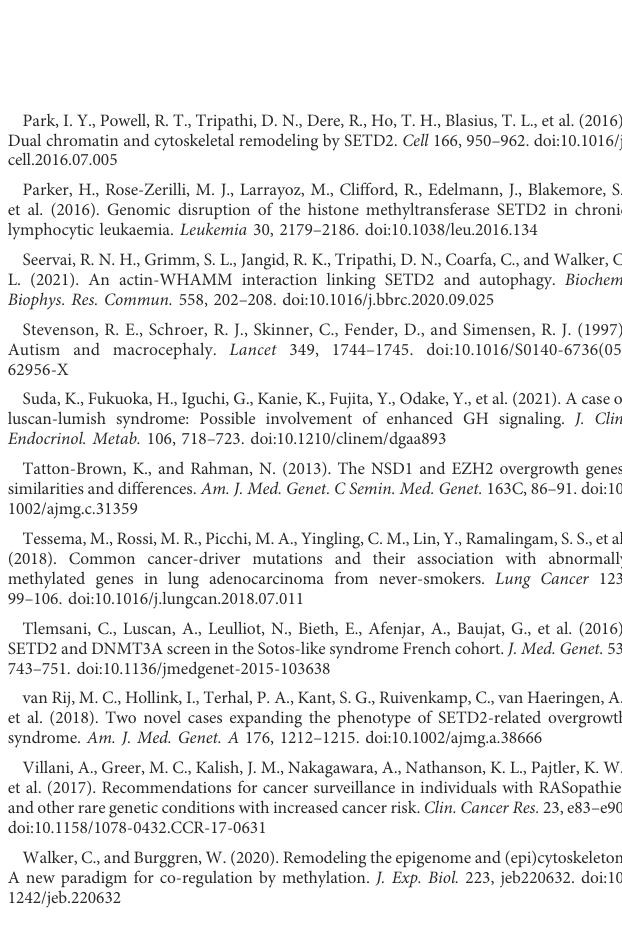
SUPPLEMENTARY FIGURE S1 Brain MRI. The left cerebral hemisphere is slightly larger, the corpus callosum is slightly shorter, the shape of the lateral ventricle is not good, frontal sinusitis. Arrows show corpus